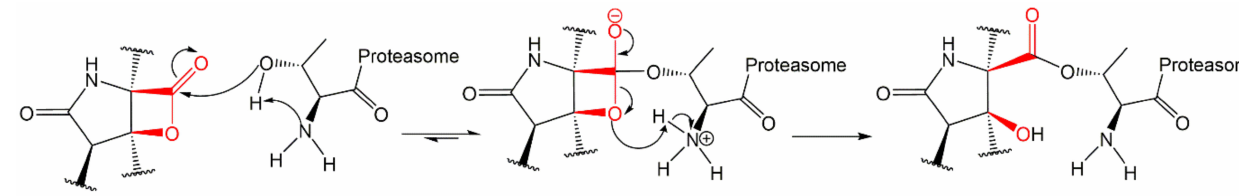
Figure 17. Examples of β -lactone inhibitors of 20S CP [27,36,73,74].